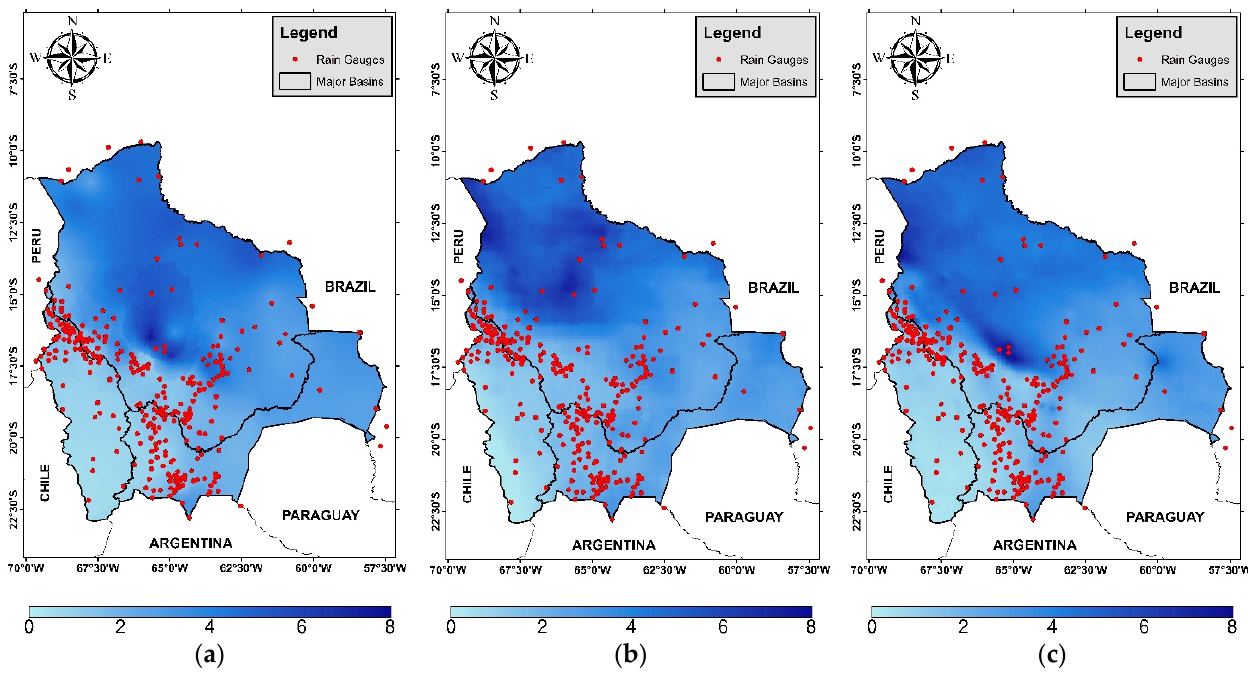
Figure 7. Average daily precipitation maps for the period 2001–2015: ( a ) rain gauges, ( b ) GSMaP_Gauge, ( c ) CHIRPS. Figure 7. ( b ) GSMaP_Gauge, ( c ) CHIRPS.